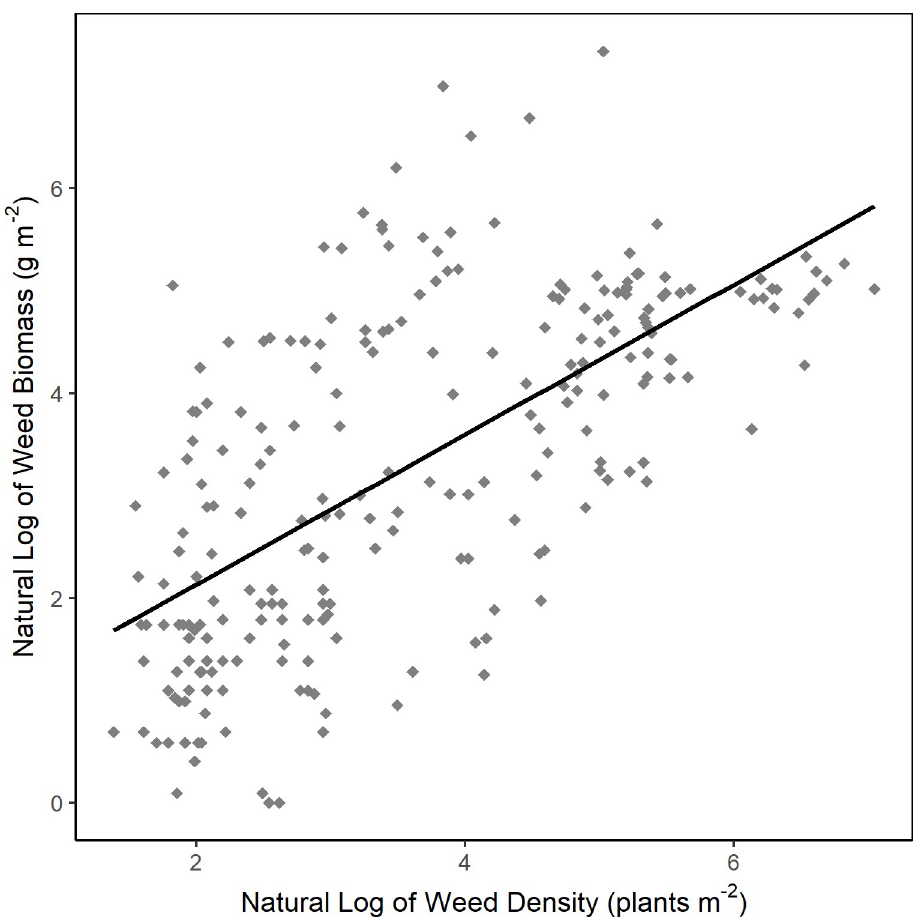
Fig 3. Relationship between weed biomass and weed density (natural log scale) for studies (n = 11) that reported both values. Line represents Spearman correlation fit.